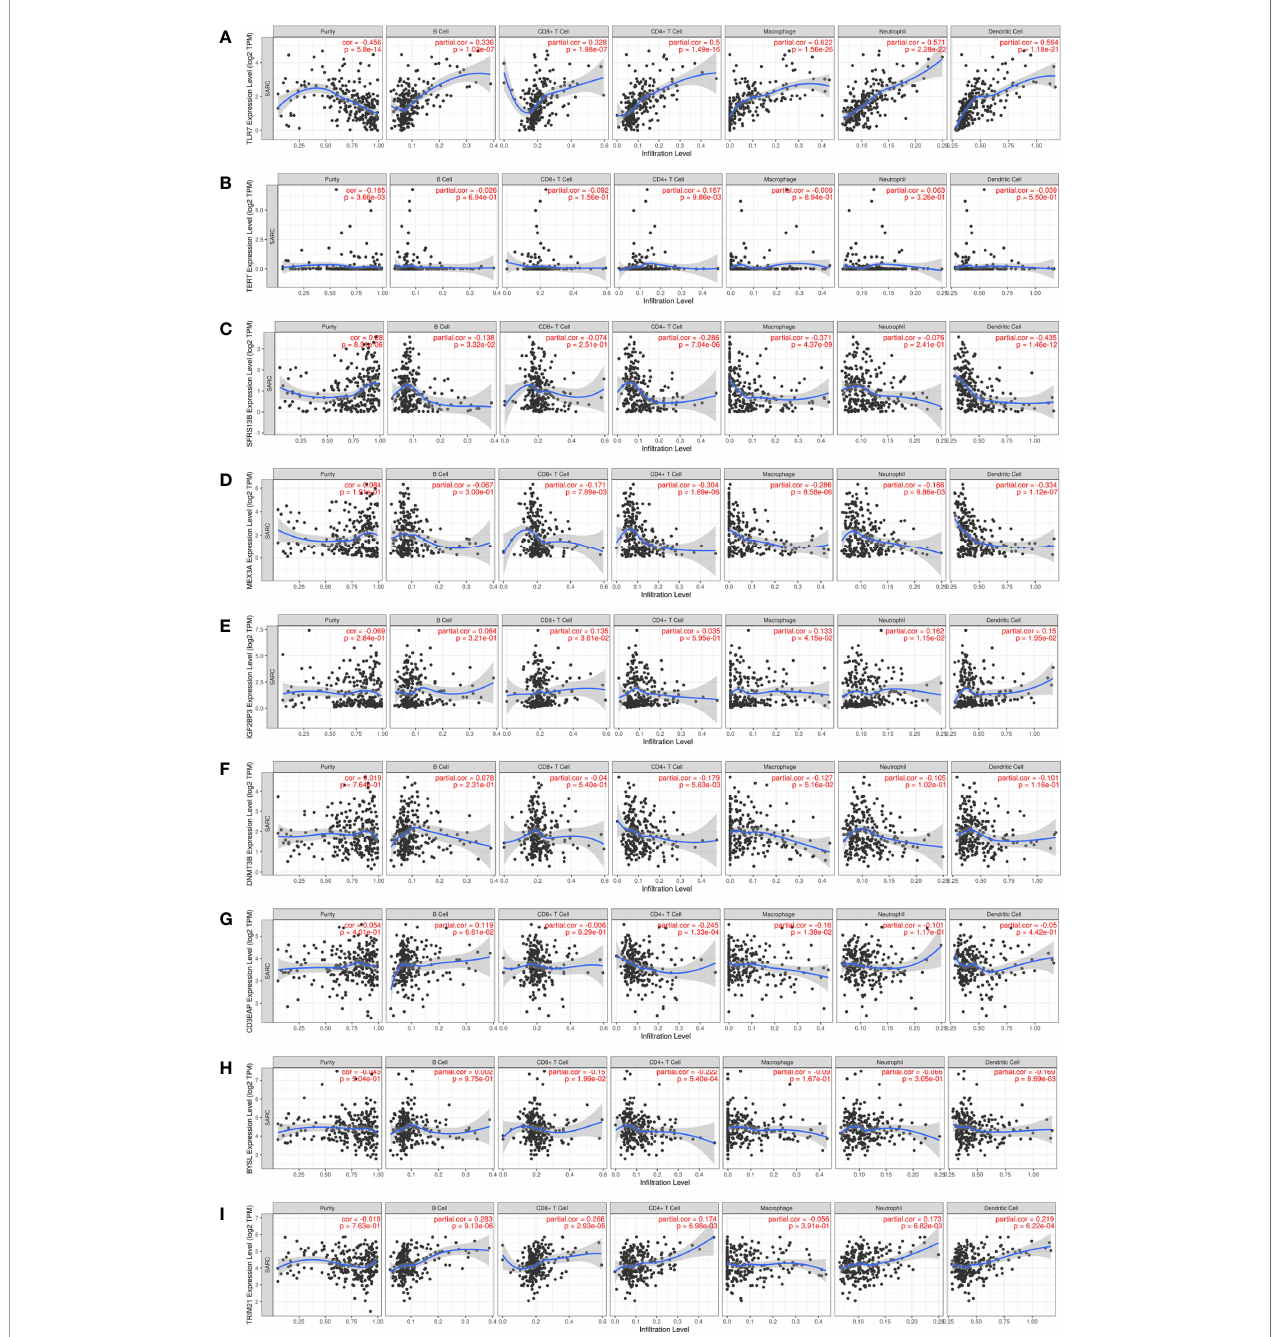
FIGURE 10 | Relationships between expression of 9 hub RBPs and tumor immune in fi ltrations. (A) TLR7, (B) TERT, (C) SRSF12, (D) MEX3A, (E) IGF2BP3, (F) DNMT3B, (G) CD3EAP, (H) BYSL and (I)